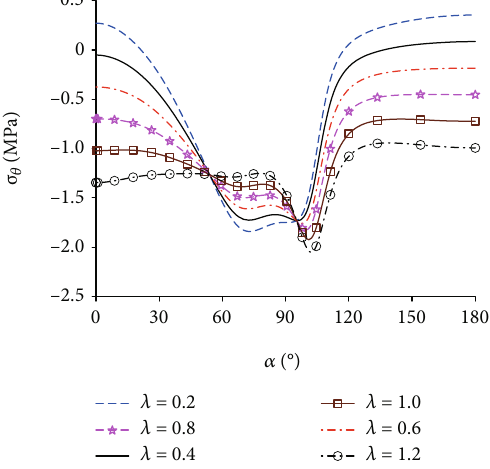
Figure 5: Comparison of stresses along the Ox -axis.